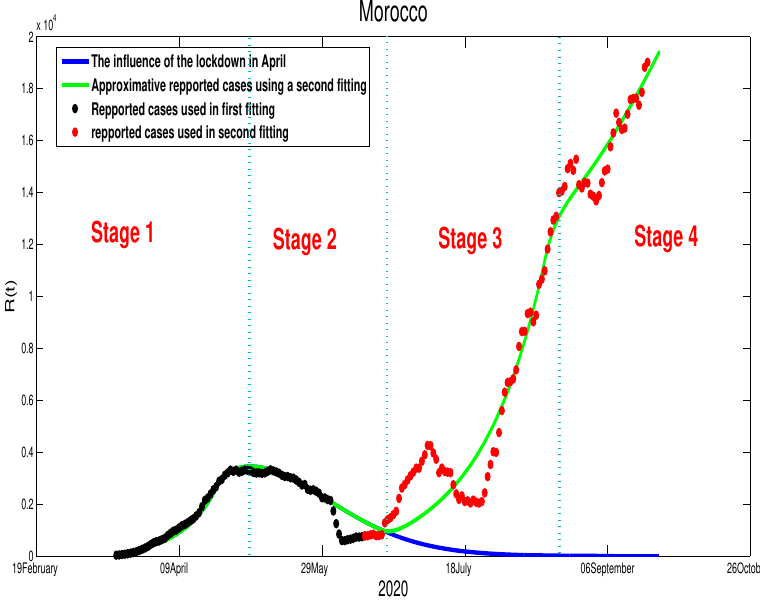
Figure 11. The new fitting of the data for COVID-19 in Morocco after the relaxation of the population mobility